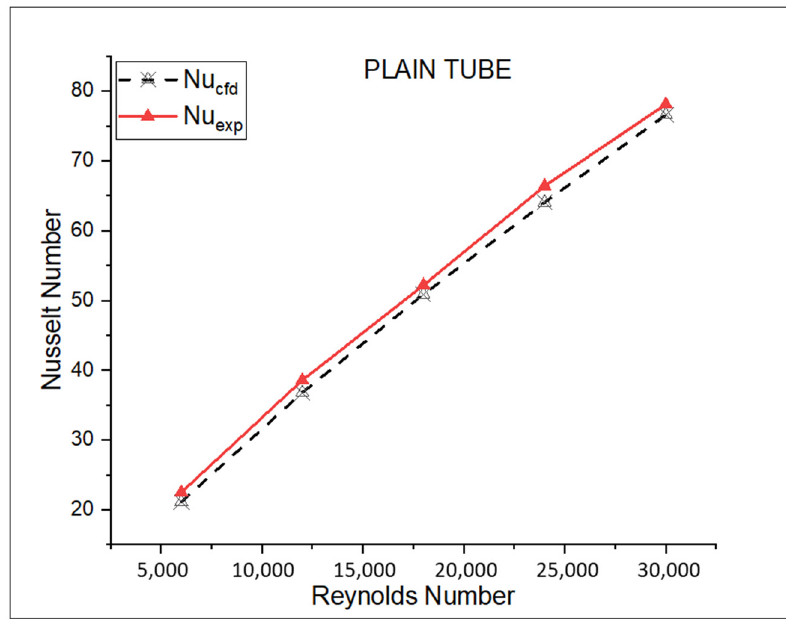
Figure 7. Study of Nu over Reynolds Number.